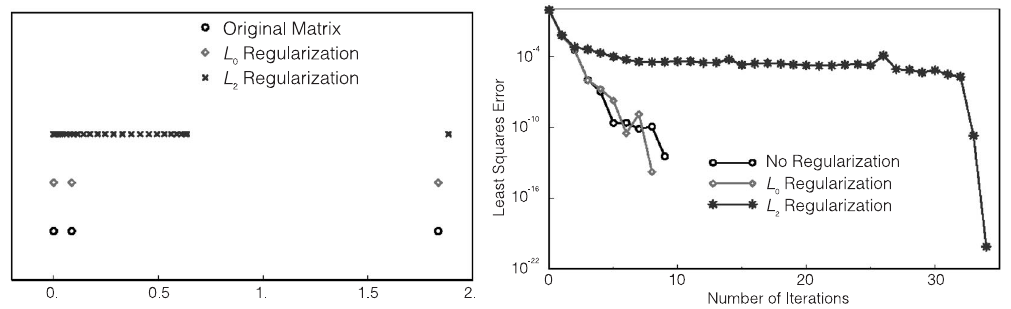
Fig. 8a,b. a) Eigenvalues of ˆ A . The largest eigenvalue of each matrix, placed around 50, is not displayed. b) Con- vergence history of the conjugate gradient algorithm with different